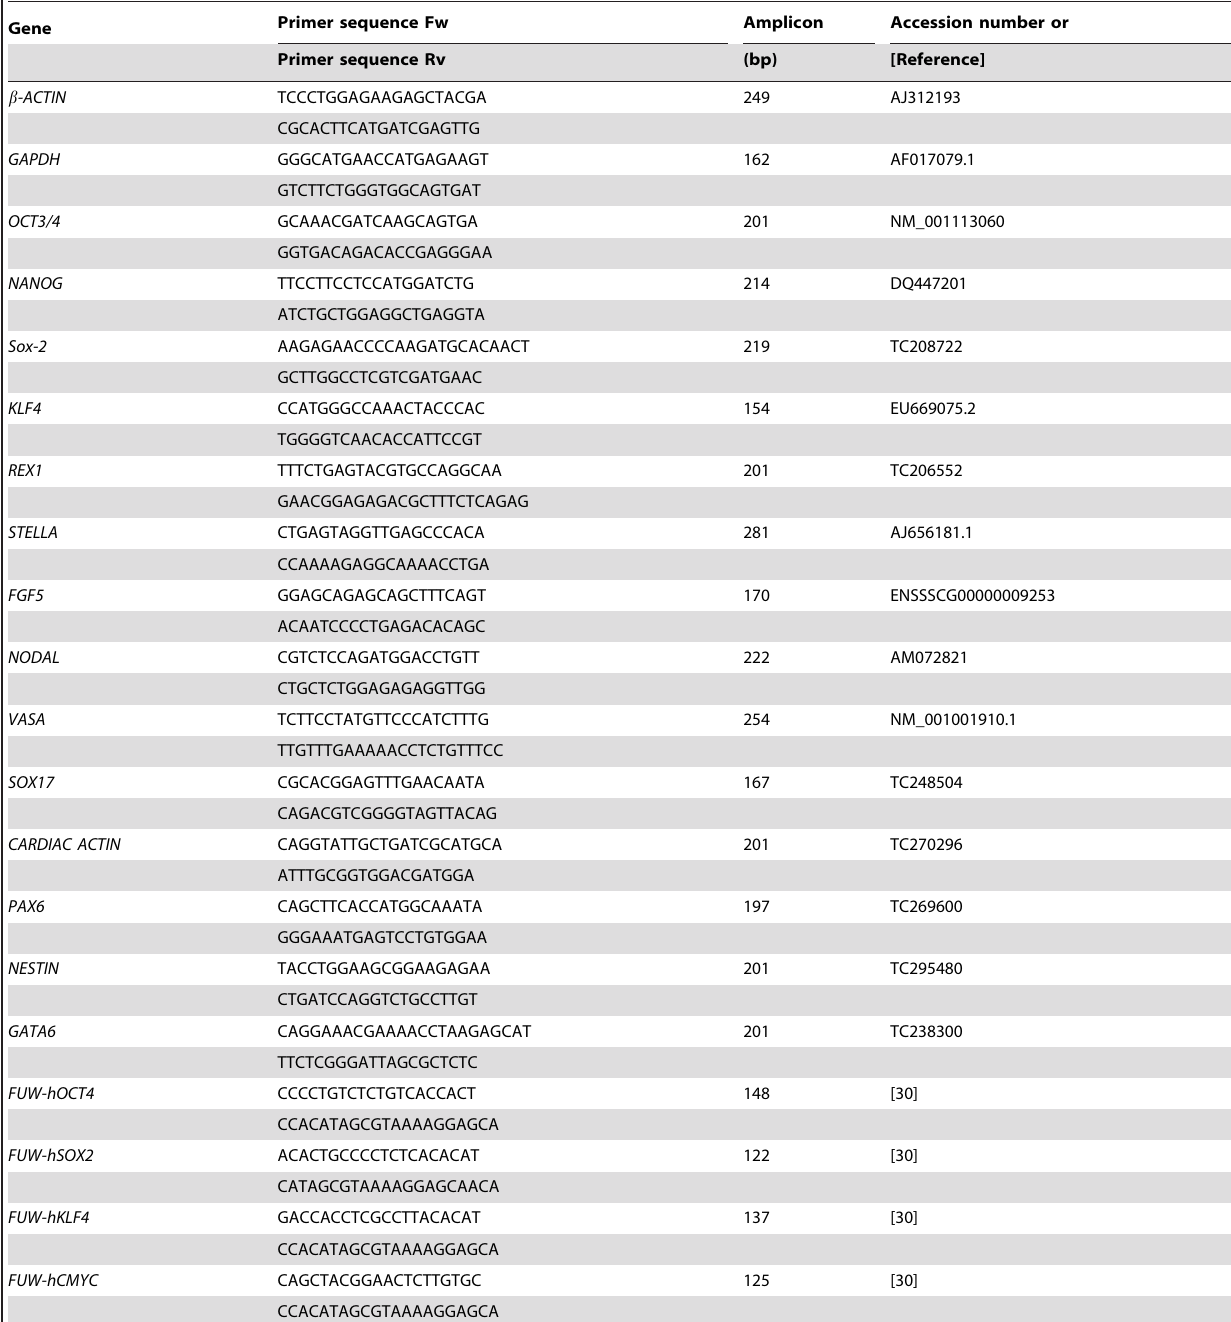
Table 1. List of primers used in this